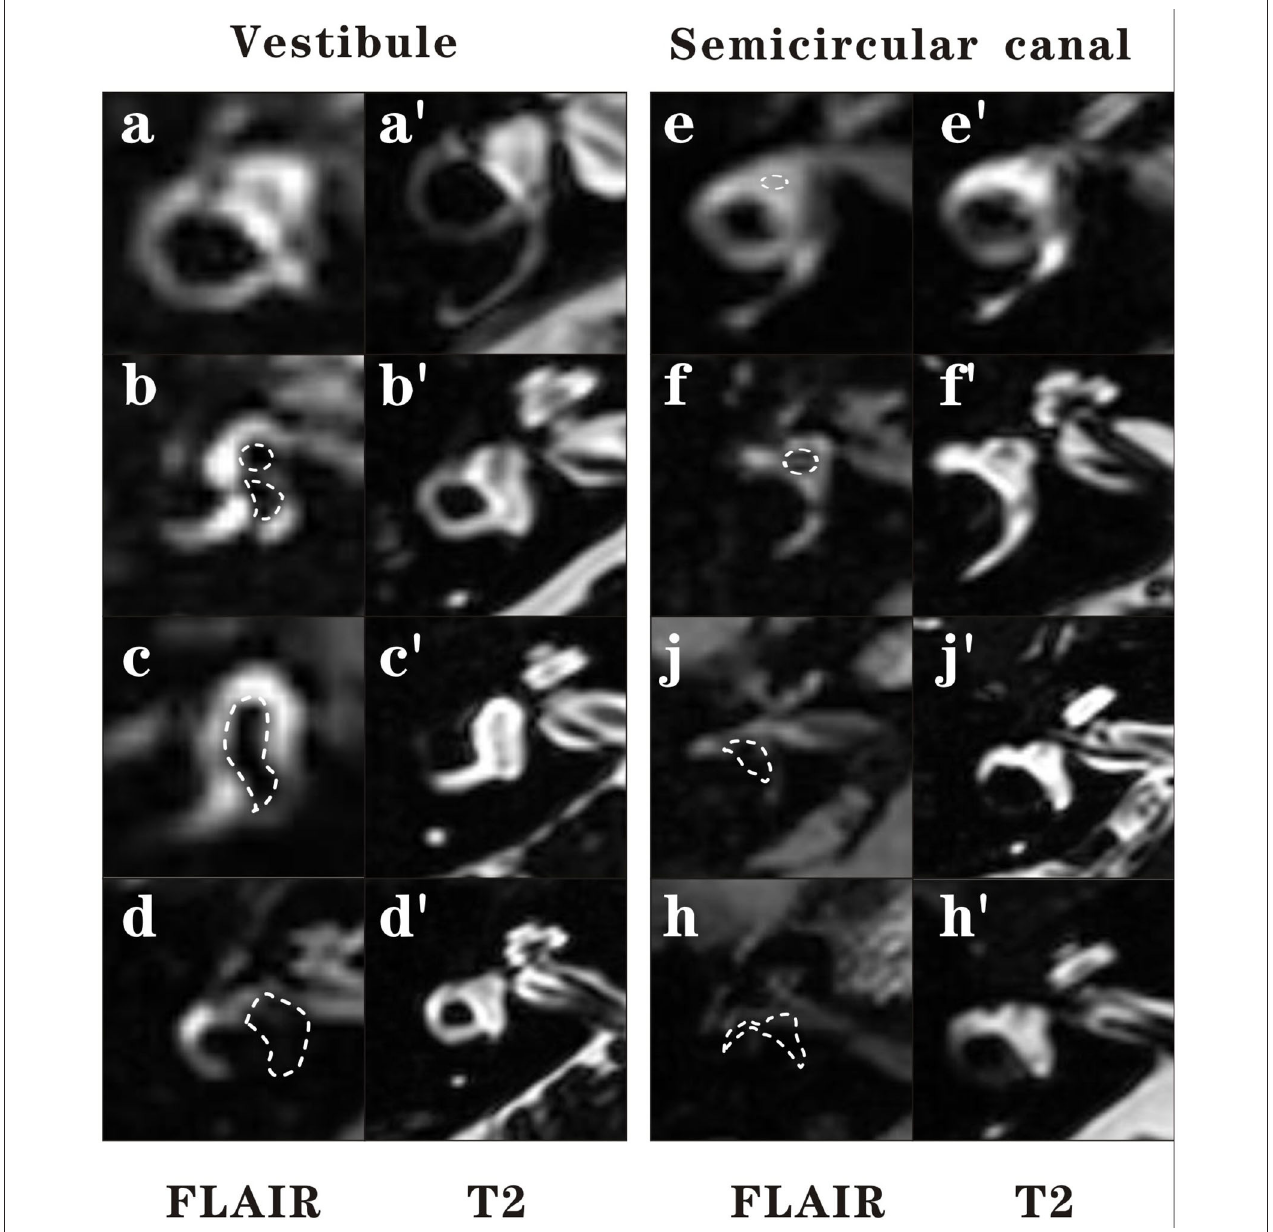
FIGURE 1 | Four grades of the vestibular EH and lateral semicircular canal EH. In this figure, 3D-FLAIR pictures (a–h) are shown adjacent to 3D-T2-SPAIR pictures (a ′ -h ′ ) for each grade. For vestibule, grade 0 = No hydrops (a) . The saccule and utricle are visibly separately and take less than half of the surface of the vestibule. Grade 1 = Mild hydrops (b) . When the saccule become equal or larger than the utricle, but is not yet confluent with the utricle. Grade 2 = Moderate hydrops (c) . There is a confluence of the saccule and utricle with still a peripheral rim enhancement of the perilymphatic space. Grade 3 = Severe hydrops (d) . The perilymphatic enhancement is invisible. For lateral semicircular canal, grade 0 = No hydrops (e) . A small visible herniation which is 1/3 less than the semicircular canal with perilymph surrounding can be observed. Grade 1 = Mild hydrops (f) . A dark area occupying over 1/3 of the ampulla is observed. Grade 2 = Moderate hydrops (g) . The crura become dark and some of the canals become invisible with hydrops, which often accompany the stenosis of canals. Grade 3 = Severe hydrops (h) . All semicircular canals were invisible.